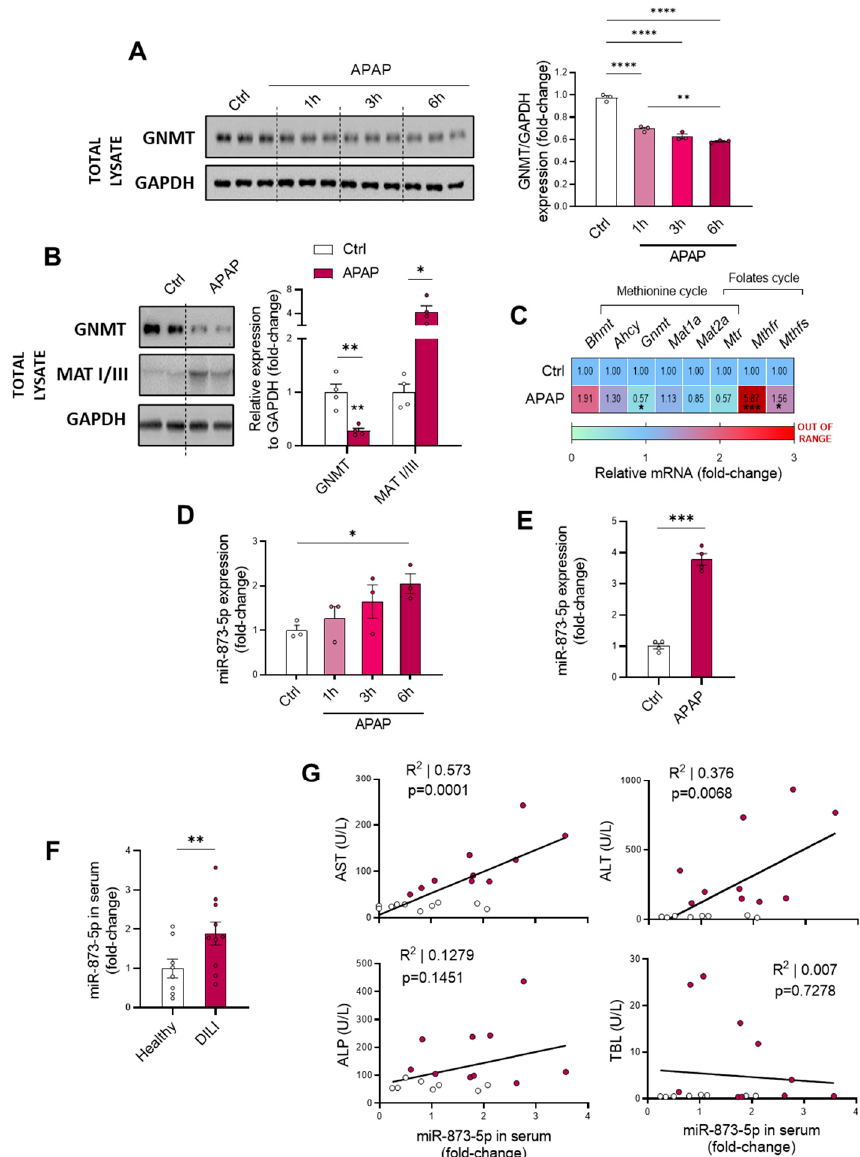
Figure 2. Glycine-N-methyltransferase (GNMT) expression is decreased in DILI by the enhanced expression of miR-873-5p. ( A ) Western blot of GNMT, loading control and respective quantification in primary hepatocytes cultured for 1, 3 and 6 h with 10 mM acetaminophen (APAP); ( B ) Western blot of GNMT and Methionine adenosyltransferase I/III (MATI/III) and relative expression of ( C ) mRNA from methionine and folates cycles enzymes in liver from mice administered 360 mg/kg APAP for 48 h. miR-873-5p expression in ( D ) primary hepatocytes cultured for 1, 3 and 6 h with APAP, ( E ) Liver from mice administered 360 mg/kg APAP for 48 h and ( F ) serum from drug-induced liver injury patients (DILI) compared to a control group or healthy individuals. ( G ) Correlation between levels in serum of miR-873-5p and aspartate aminotransferase (AST), alanine. aminotransferase (ALT), alkaline phosphatase (ALP) and total bilirubin (TBL) from DILI patients compared to healthy individuals. * p < 0.05, ** p < 0.01, *** p < 0.001 and **** p < 0.0001 are